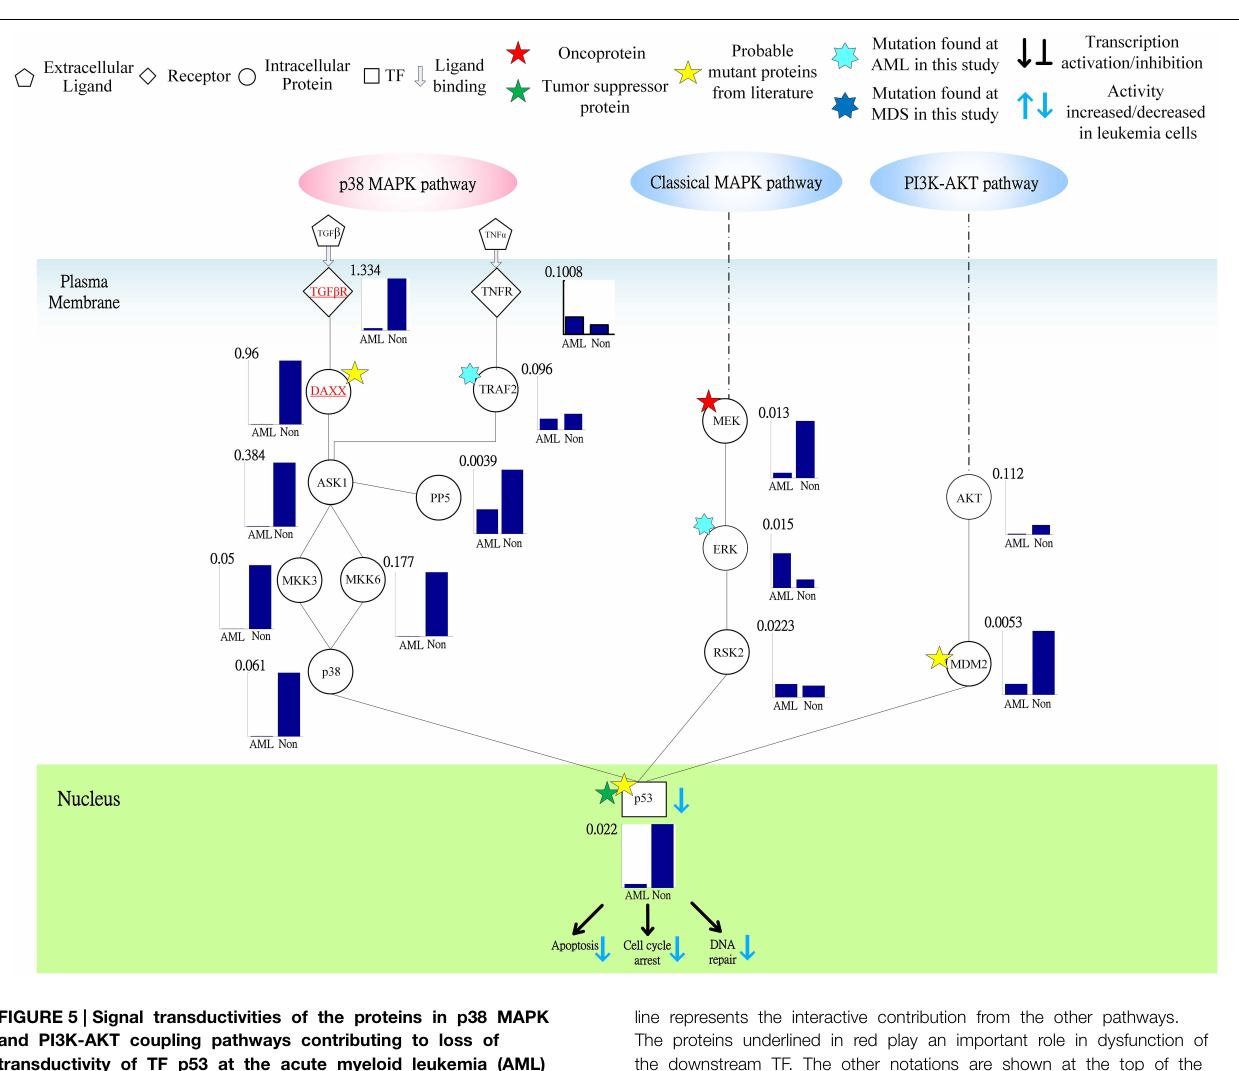
FIGURE 5 | Signal transductivities of the proteins in p38 MAPK and PI3K-AKT coupling pathways contributing to loss of transductivity of TF p53 at the acute myeloid leukemia (AML) subtype when compared with normal type. The solid line represents the PPIs in the plasma membrane, while the dot-and-dash